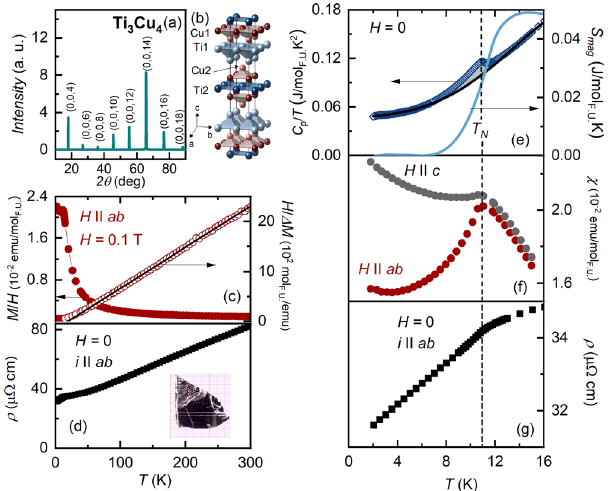
Fig. 1 Antiferromagnetic order in Ti 3 Cu 4 . a X-ray diffraction pattern of single crystalline Ti 3 Cu 4 with the beam incident on the as grown surface showing a series of (00 l ) Bragg re fl ections. b The tetragonal crystal structure of Ti 3 Cu 4 , composed of alternating layers of Ti (blue) and Cu (red), with two unique crystallographic sites for each, indicated by the dark and light shading. c The temperature dependent magnetization scaled by fi eld M / H (left axis, fi lled circles) measured with an applied fi eld H = 0.1 T parallel to the ab plane, shows a cusp at the Néel temperature T N = 11.3 K. The inverse susceptibility H / Δ M (right axis, open circles) is fi t with a Curie- Weiss-like equation (black line) which gives a paramagentic moment μ = 1.0 μ * = 19.4 PM B per formula unit (F.U.) and Weiss-like temperature T K. d Temperature dependent resistivity ρ with current i ∥ ab showing a sharp decrease at T N . (inset) A typical single crystal of Ti 3 Cu 4 with the grid lines spaced 1mm apart. e The heat capacity scaled by temperature C p / T (left axis) exhibits a peak at T N . The non-magnetic contribution was fi t to a polynomial (black line). The calculated entropy S mag (right axis) saturates at just 0.8% of R ln2. f The H → 0 magnetic susceptibility χ ( T ) derived from the fi eld dependent derivative of magnetization discussed in Supplementary Note 1, showing an AFM cusp with H ∥ ab (red symbols), while χ ( T ) plateaus for H ∥ c (grey symbols). g Zoomed in resistivity showing the anomaly at 11.3 K that coincides with the anomalies in susceptibility and heat capacity at T N (dashed